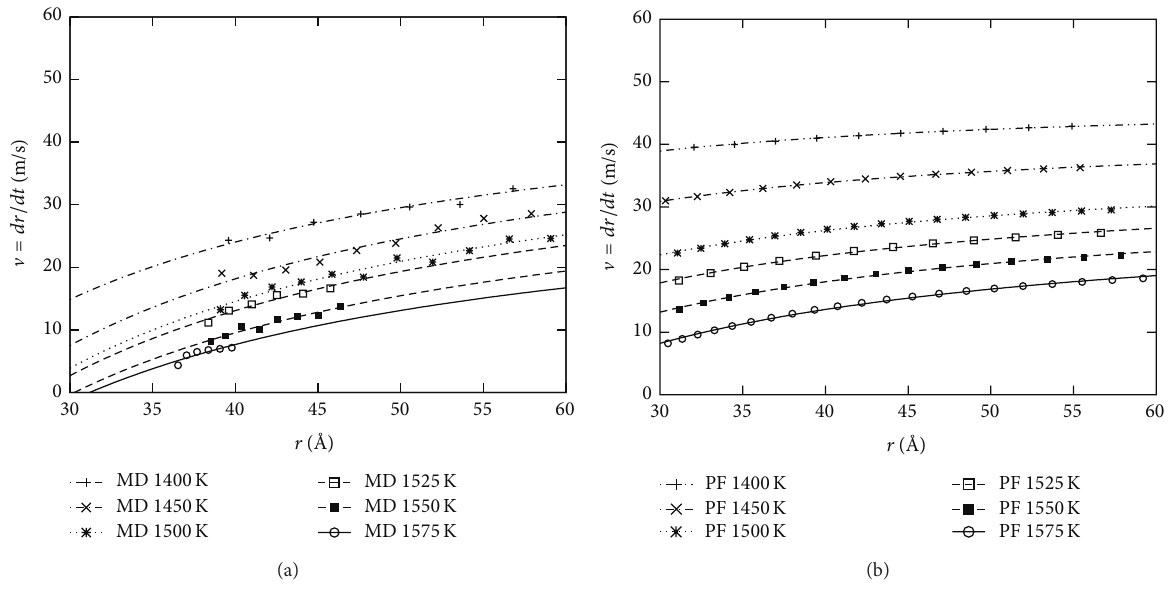
Figure 5: Evolution of the radial velocity at different temperatures. Molecular dynamic (a) and phase-field (b). In lines the fits V 𝑇 (𝑟) := + 𝑏 /𝑟 . 𝑎 𝑇 𝑇